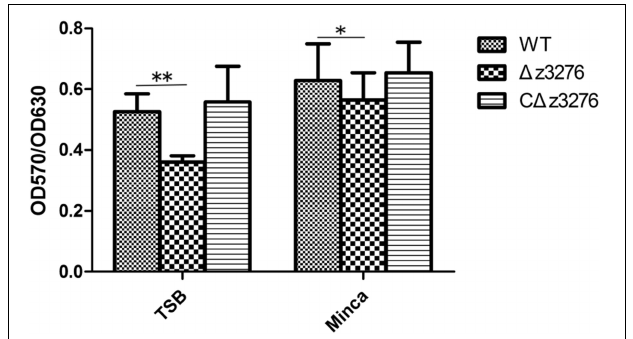
FIGURE 3 | (cid:49) z3276 decreases biofilm formation in TSB medium and modified Minca medium at 37 ◦ C without shaking after 10 h in 96-well plates. Total biofilm formation (OD 570 ) was normalized by bacterial growth (OD 630 ). The experiment was performed in triplicate, and data represent the mean ± SEM of three independent experiments. ∗ Indicates significance at P < 0.05; ∗∗ Indicates extreme significance at P < 0.01.